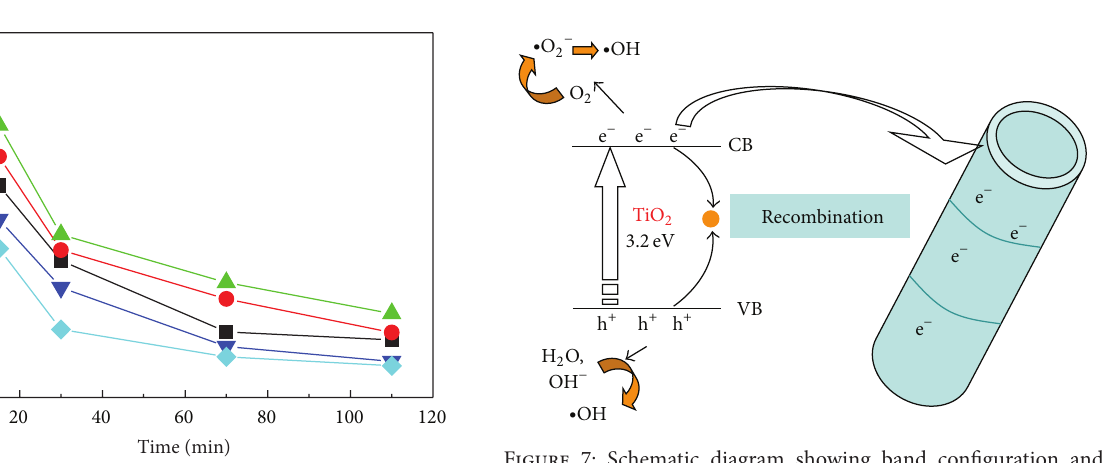
Figure 7: Schematic diagram showing band configuration and electron-hole separation at interface of TiO 2 -CNx nanocomposites under UV irradiation (CB: the bottom of conduction band, VB: the top of valence